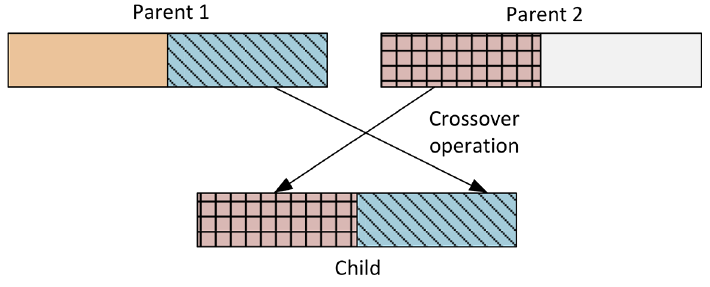
Fig 5. Crossover